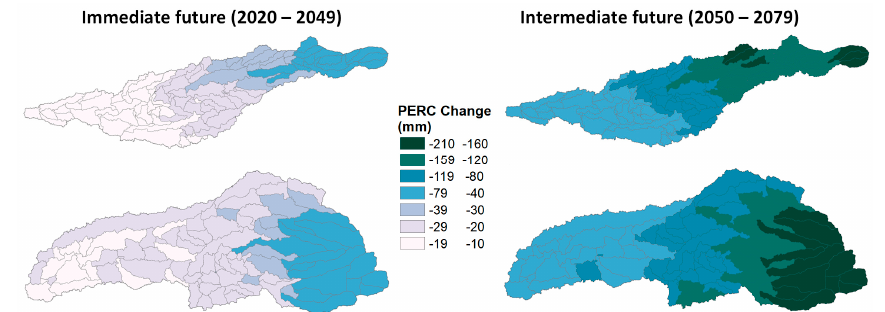
Figure 7. Changes in the yearly average percolation (PERC) at the sub-basin scale, using RegCM4-MPI-ESM-MR, scenario RCP8.5.